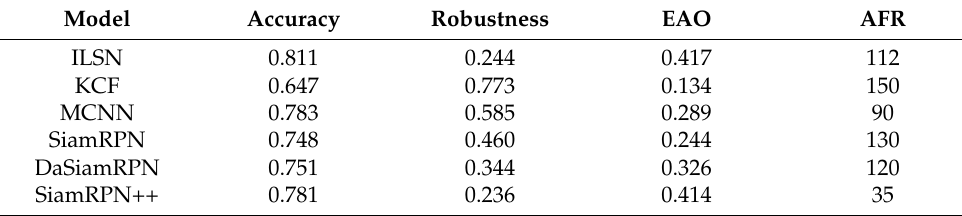
Table 4. Results of the comparative experiment under 4 different scenarios.